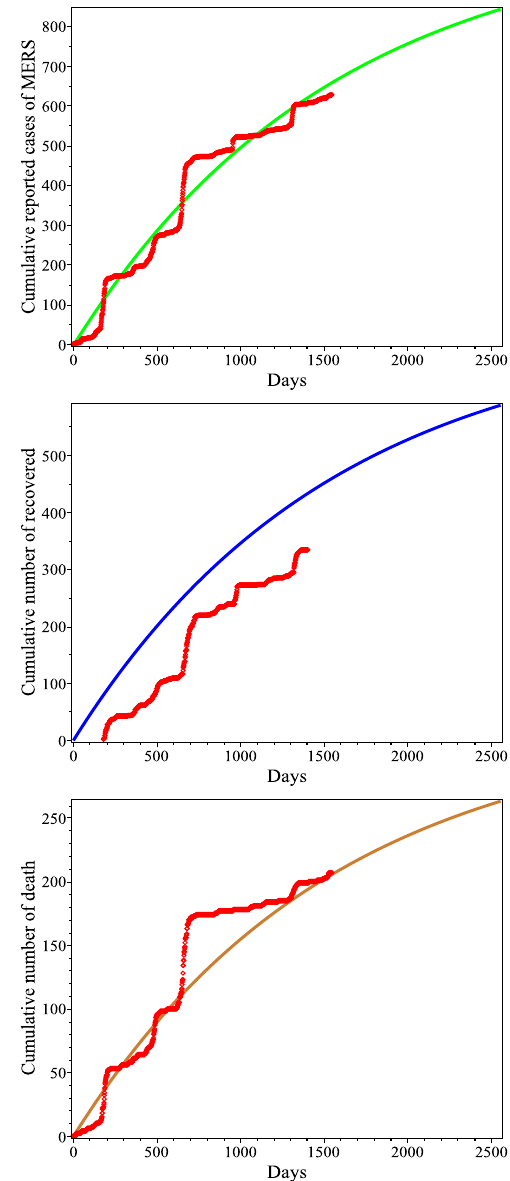
Fig. 5: Riyadh baseline simulations of cumulative cases of MERS (T) - green curve; cumulative number of recovered (M) - blue curve; and cumulative number of death (B) - brown curve. The red dots are the field data. The run was for 2555 days ( ∼ 84